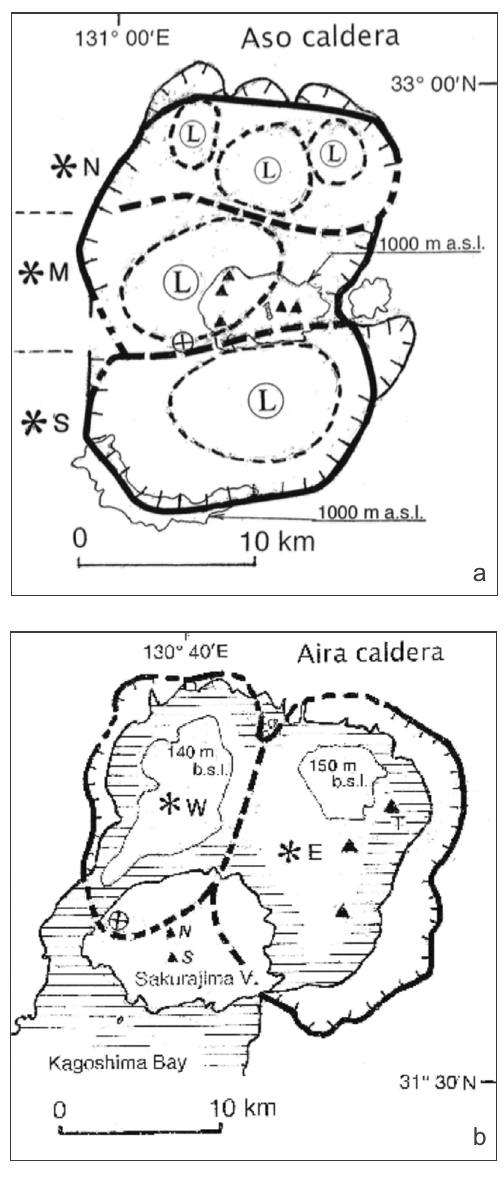
Figure 3. Composite calderas in Kyushu, Japan, Aso and Aira: hatchured contours indicate the present caldera rims. ⊕ denotes drilling sites. Thick solid lines outline the caldera formed by amal- gamation of component calderas. (a) Aso: Ⓛ denotes a residual low gravity anomaly and triangles denote active cones. ( ✻ N), ( ✻ M) and ( ✻ S) are component calderas and amalgamated to form Aso caldera. (b) Aira: thin outlines in the sea area of both ( ✻ W) and ( ✻ E) show flat bottoms, respectively. Triangles in ( ✻ E) are vents: “T” is active and another two are extinct. N and S on Sakurajima volcano denote extinct North Peak and active South Peak,